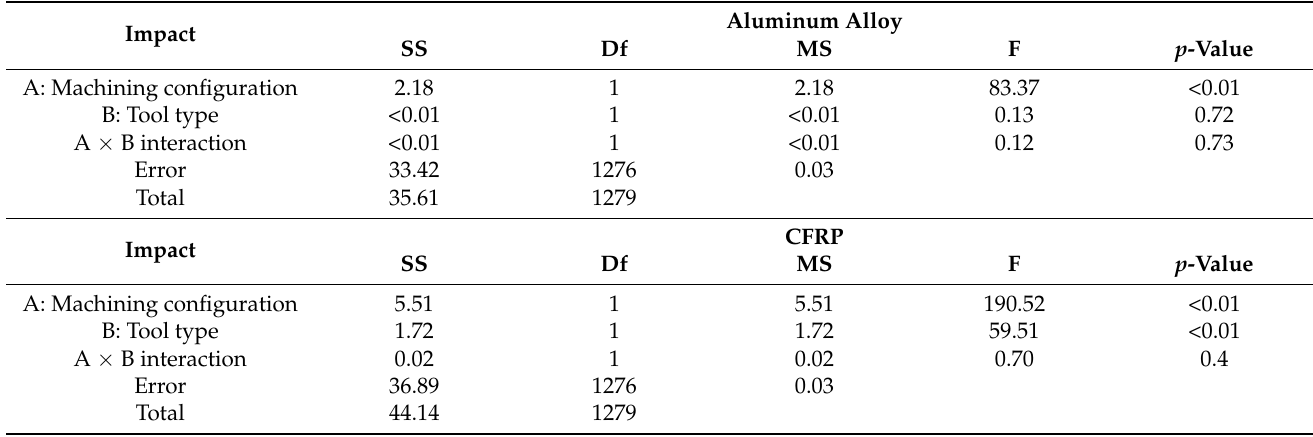
Table 3. Two-factor analysis of variance for Ra surface roughness parameter depending on the machining configuration and the type of tool.